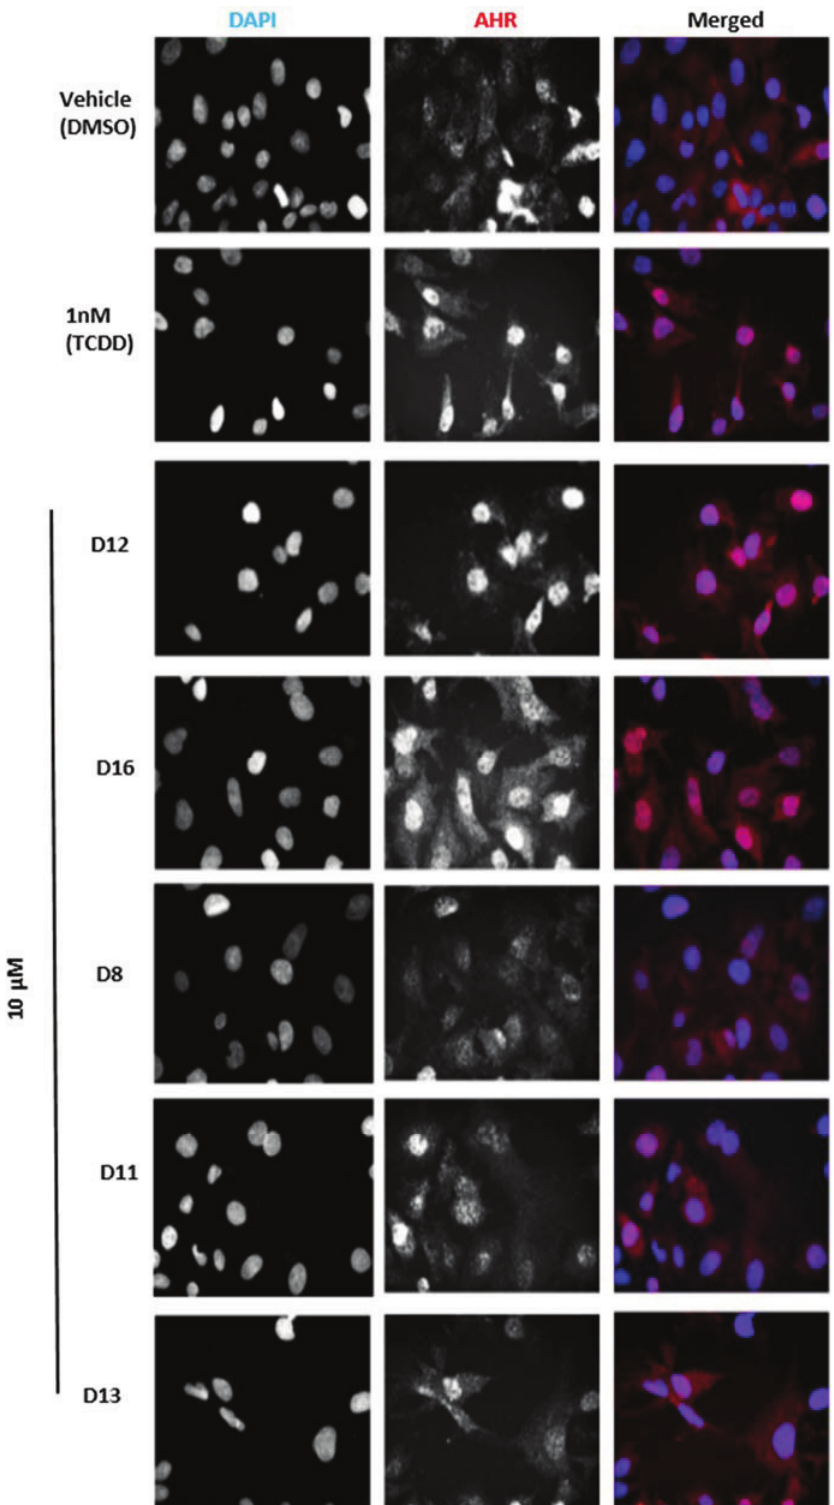
Figure 6. Subcellular localization of AHR in HepG2 cells. Cells were treated with the indicated compounds at 10 μM for 120 min, fixed, and then immunostained with AHR followed by cyanine3 (Cy3)-conjugated secondary antibody. Cells were stained by 4,6-diamino-2-phenylindole (DAPI) to visualize nuclei and were imaged by ImageXpressMICRO wide-field high content imaging system. Experiments were run in